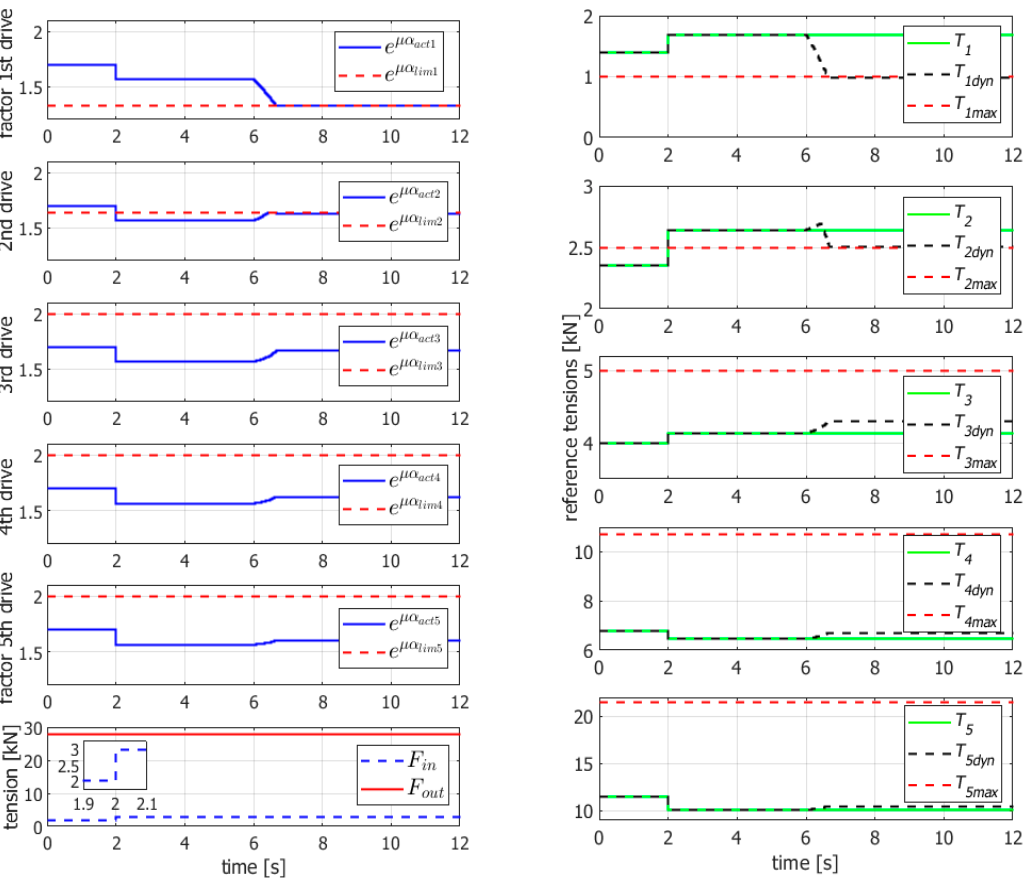
Figure 5. Simulation results. The left-hand picture shows actual and limit factors for each drive. The right-hand picture shows tension setpoints and tension limits. Time t = 0 s to 6 s is for the uniform distribution of tensions; time t = 6 s to 12 s is for the dynamic distribution of tensions.